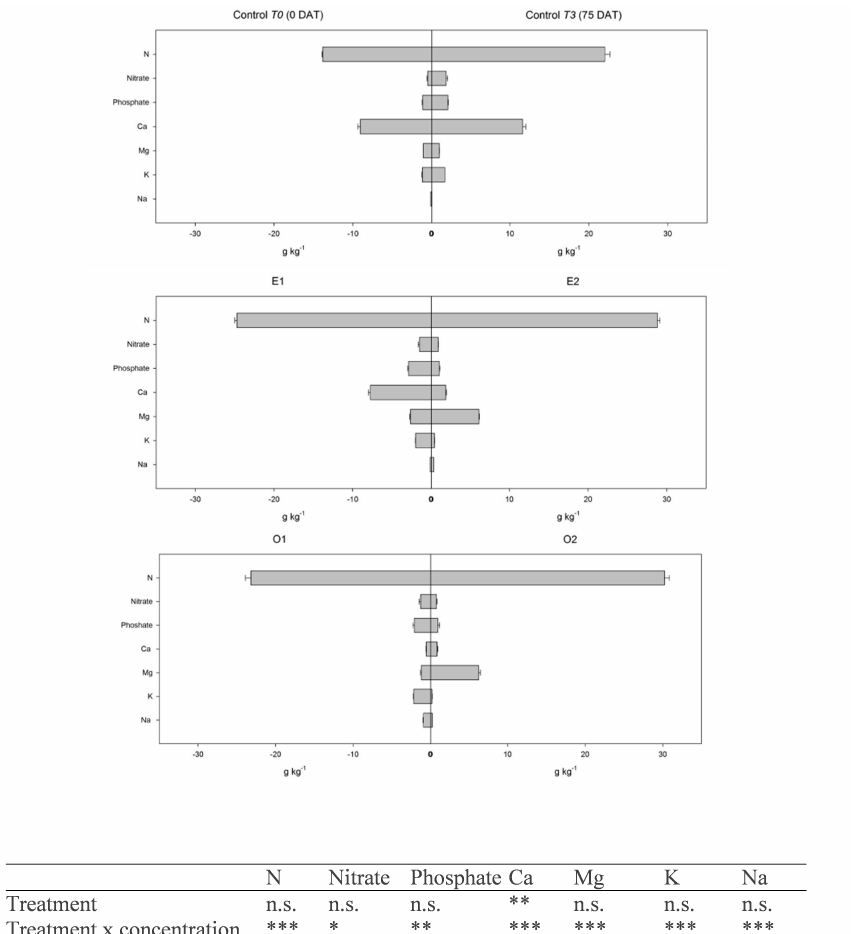
Figure 6. Nutrient analysis in costmary plants at 75 DAT. Control T0 at 0 DAT, Control T3 = only water at 75 DAT, E1 = EM 5%, E2 = EM 10%, O1 = OMW 2.5%, O2 = OMW 5%. Significance analysis was performed among Control T3 and the treatments (E1, E2, O1, O2). n.s. = non significant or *, **, *** = significant at p < 0.05, p < 0.01 and p < 0.001,